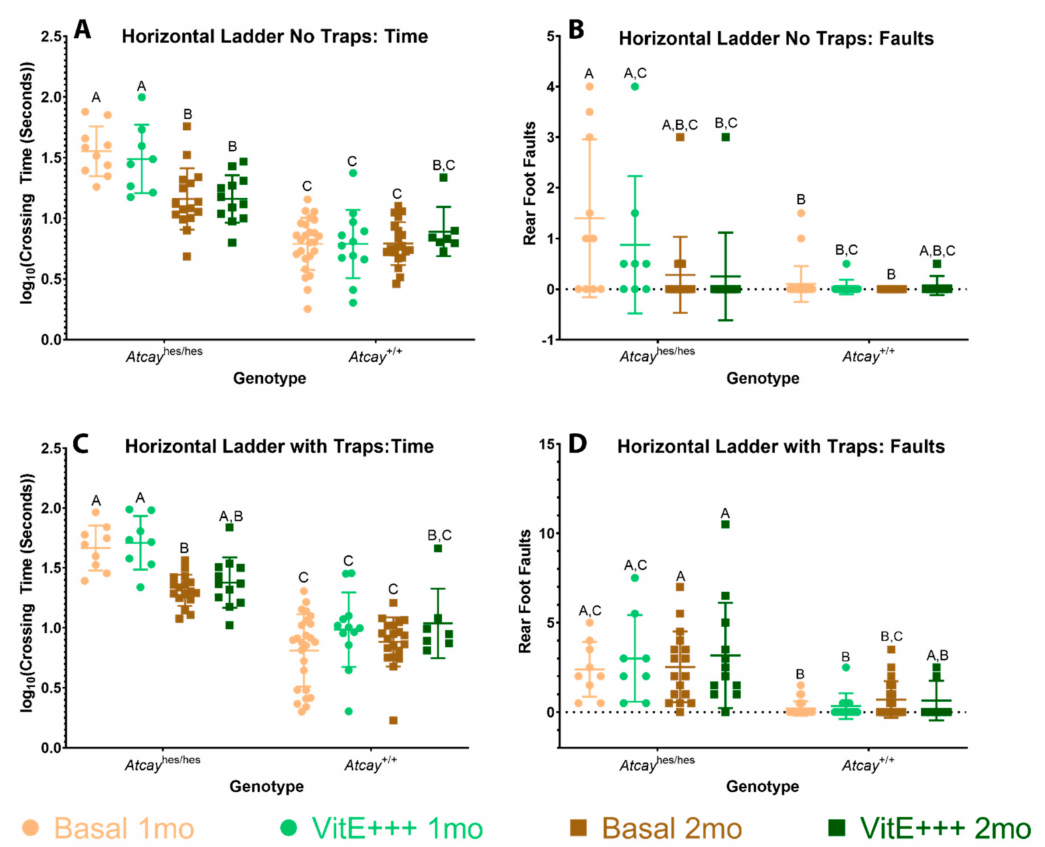
Figure 3. Atcay hes / he s mice have di ffi culty crossing the horizontal ladder. Average crossing time ( A ) and rear foot faults ( B ) for the test without traps. Average crossing time ( C ) and rear foot faults ( D ) for the test with four evenly spaced traps. Crossing time typically segregates the genotypes. All groups were compared using Tukey’s post-hoc comparisons. Letters signify significance ( p < 0.05) between